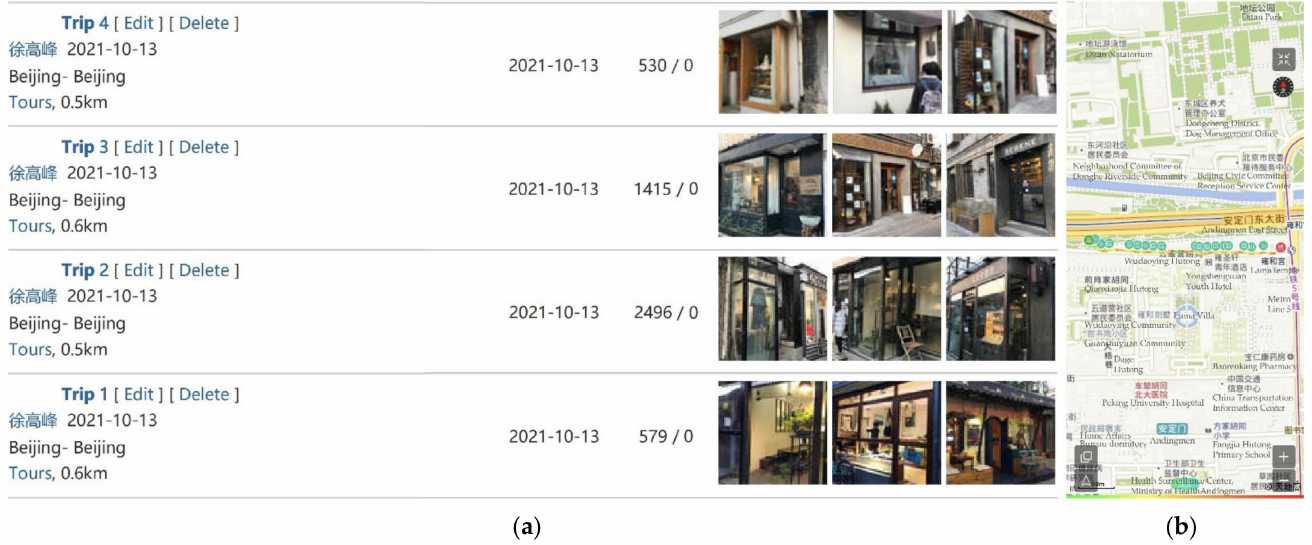
Figure 5. Part of the records of tourists’ walking-stopping behaviors: ( a ) screenshot of the recorded micro-scale built environment; ( b ) the route tracking of one surveyed